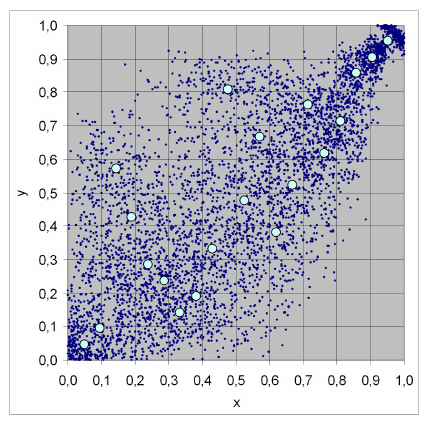
Figure 18: "Worst case" negative binomial copula, a = b = 10